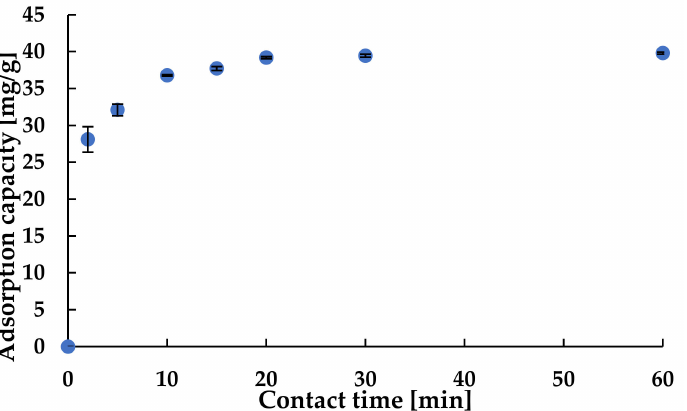
Figure 4. Plot of sorption capacity versus time for a 100 mg/dm 3 mercury